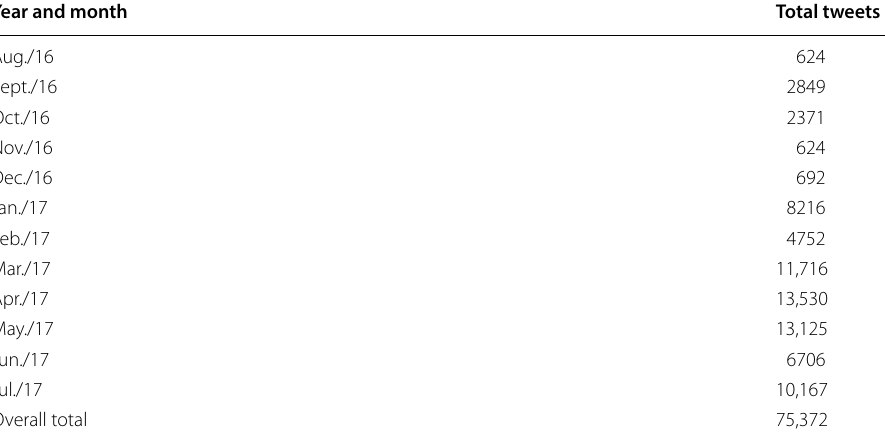
Table 3 Total tweets collected per month and year. Source: Prepared by the author Year and month Total tweets